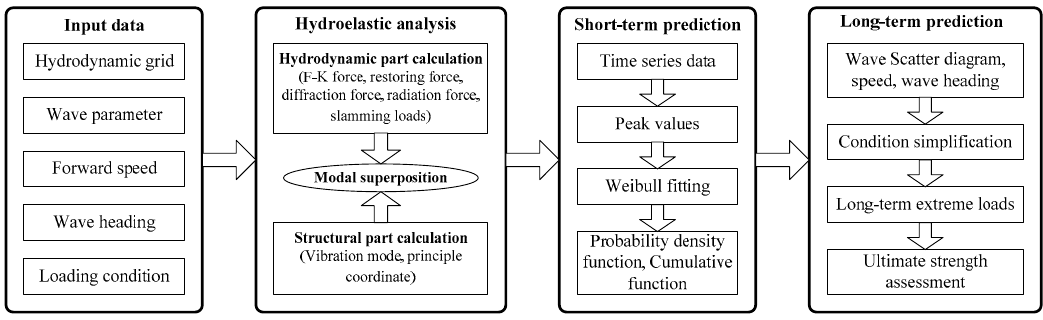
Figure 17. Flowchart of the wave loads prediction and ultimate strength assessment.